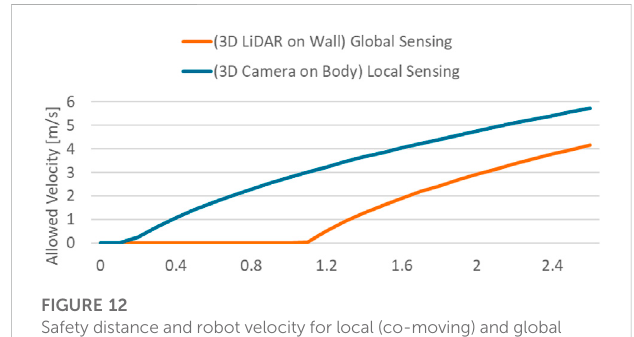
FIGURE 12 Safety distance and robot velocity for local (co-moving) and global collision